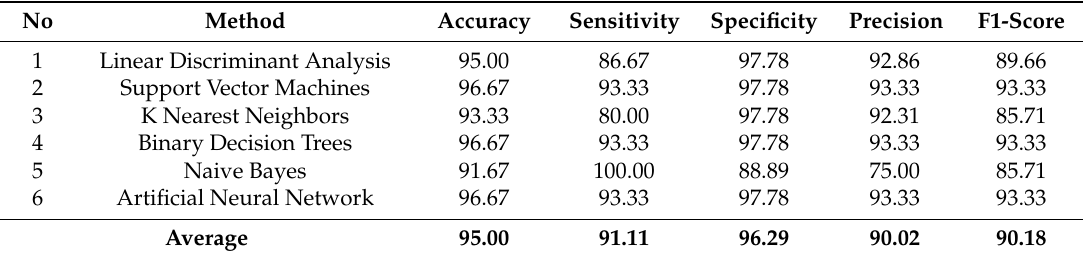
Table 1. The assessment of the proposed